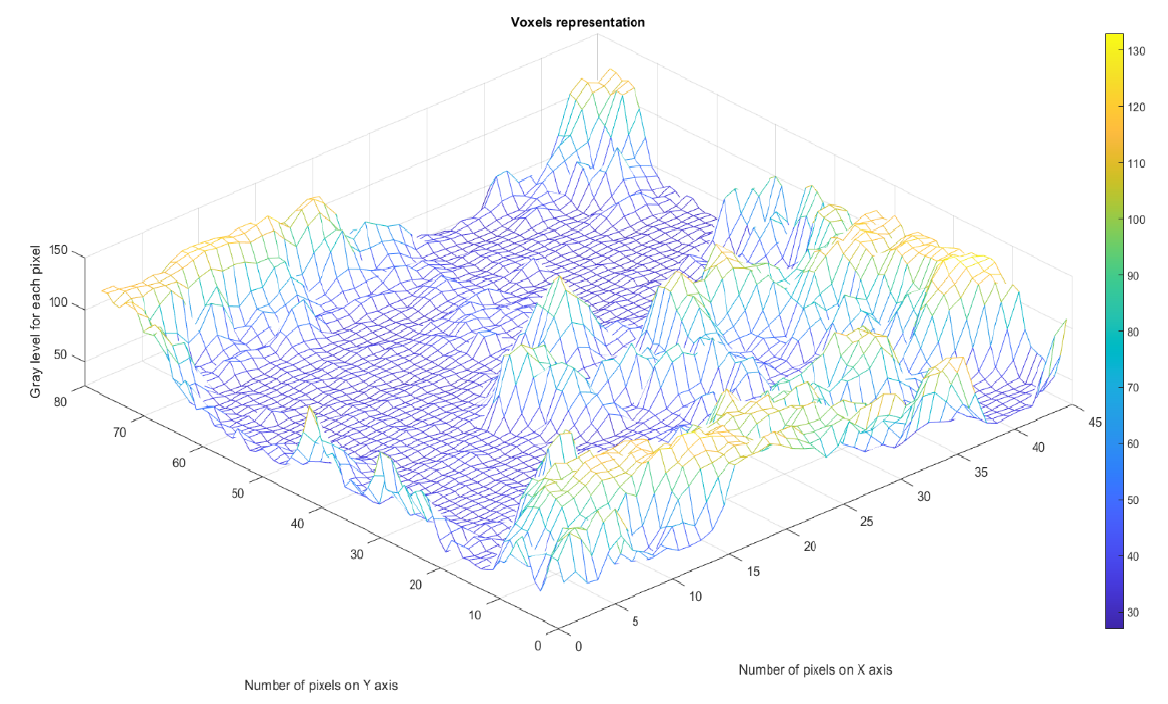
Figure 12. Voxel representation of the image in the affected/modified area.